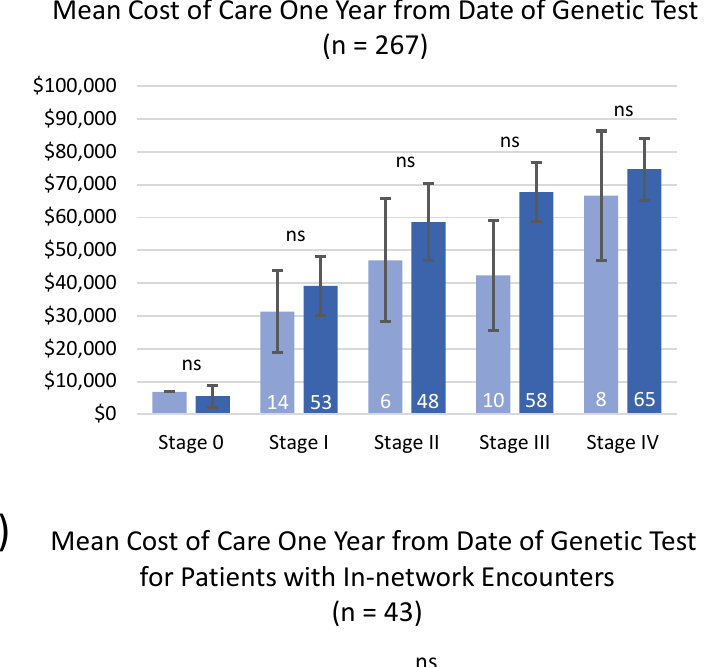
Mean Cost of Care One Year from Date of Genetic Test